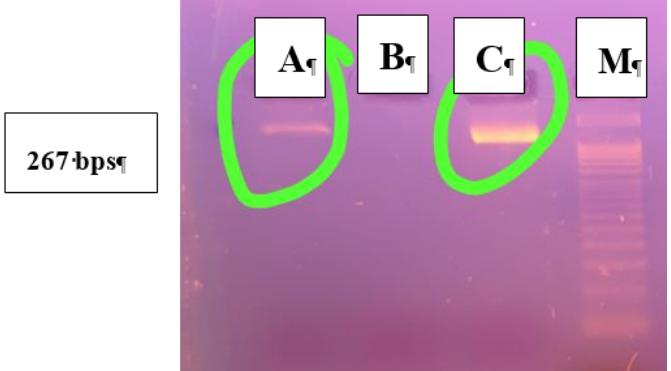
Figure 1. Ethidium bromide-stained agarose gel of the PCR products from genus-specific conventional PCR of Babesia infected dog blood samples. Lane L shows a DNA marker. Lanes from “A” to “C” are samples from naturally infected dogs showing a band of 339 bps .